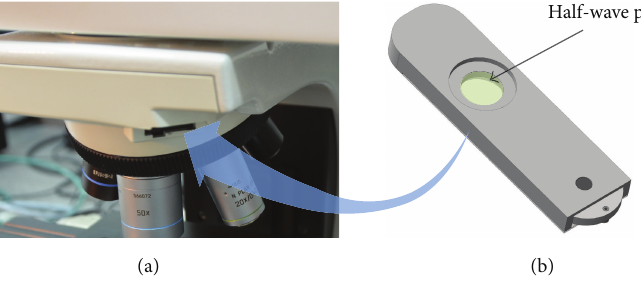
Figure 1: (a) 45 ∘ slot for the 𝜆 -plate of the microscope in the Raman system, (b) miniaturization-designed 180 ∘ continuous